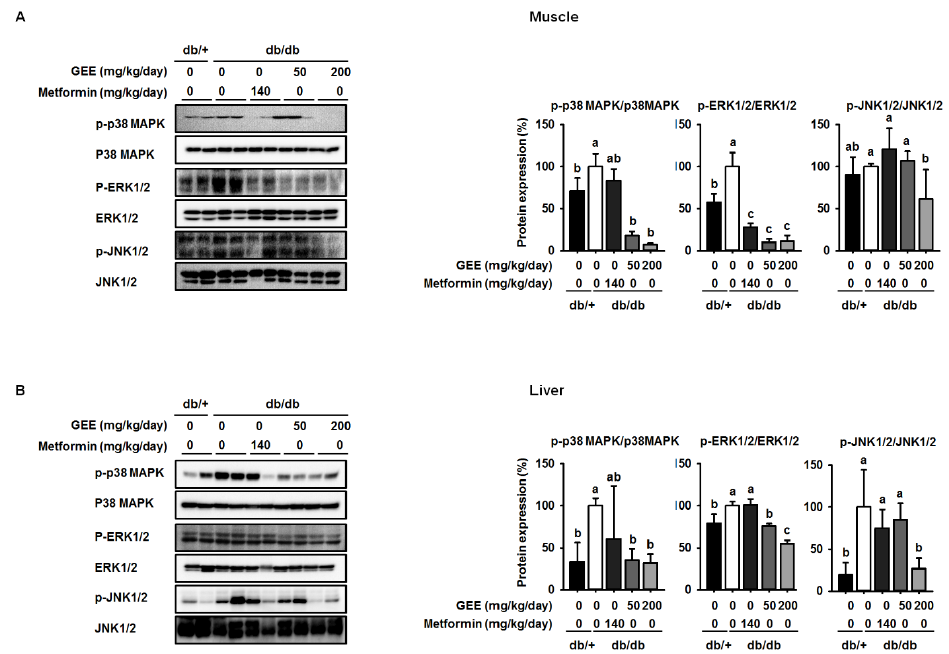
Figure 5. GEE suppresses mitogen-activated protein kinase (MAPK) pathway activation in db/db mice. Five-week old mice were administered with or without GEE (50 and 200 mg/kg/day) for five weeks. p-p38 MAPK, p-ERK1/2, and p-JNK1/2 were evaluated by western blotting in the skeletal muscle ( A ) and liver ( B ). Phosphorylation levels were quantified after normalization to the total p38 MAPK, ERK1/2, and JNK1/2 protein, respectively, using Image J software. Data were analyzed by a one-way ANOVA followed by Duncan’s test. Data are mean ± SD ( n = 8 per group, a p < 0.05, b p < 0.01, c p <